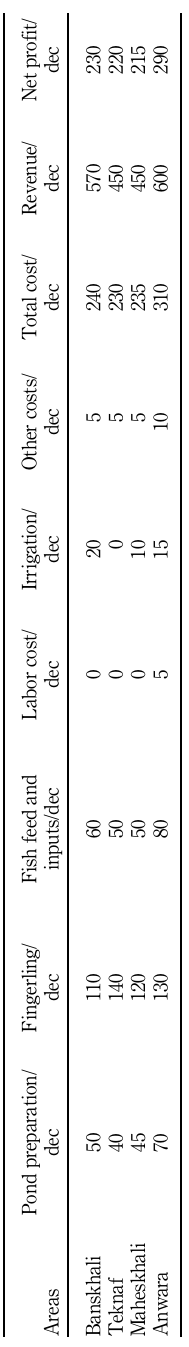
Table 13. Site specific average cost-benefit for fish culture (BDT) (1$ 5 78